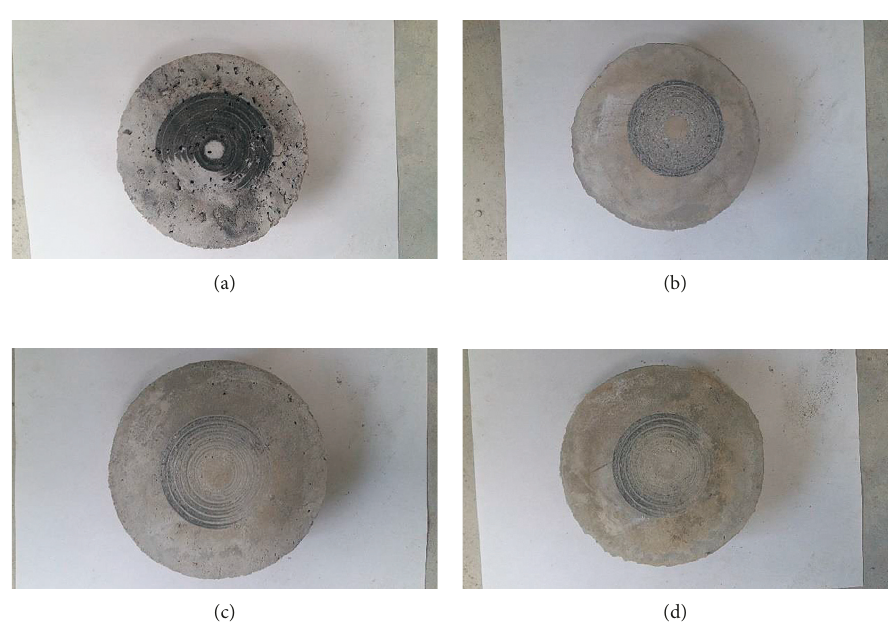
Figure 22: Photo of abrasion specimens after abrasion. (a) 40MPa (control). (b) 40MPa (optimum). (d) 60 MPa (control). (d) 60MPa (optimum).